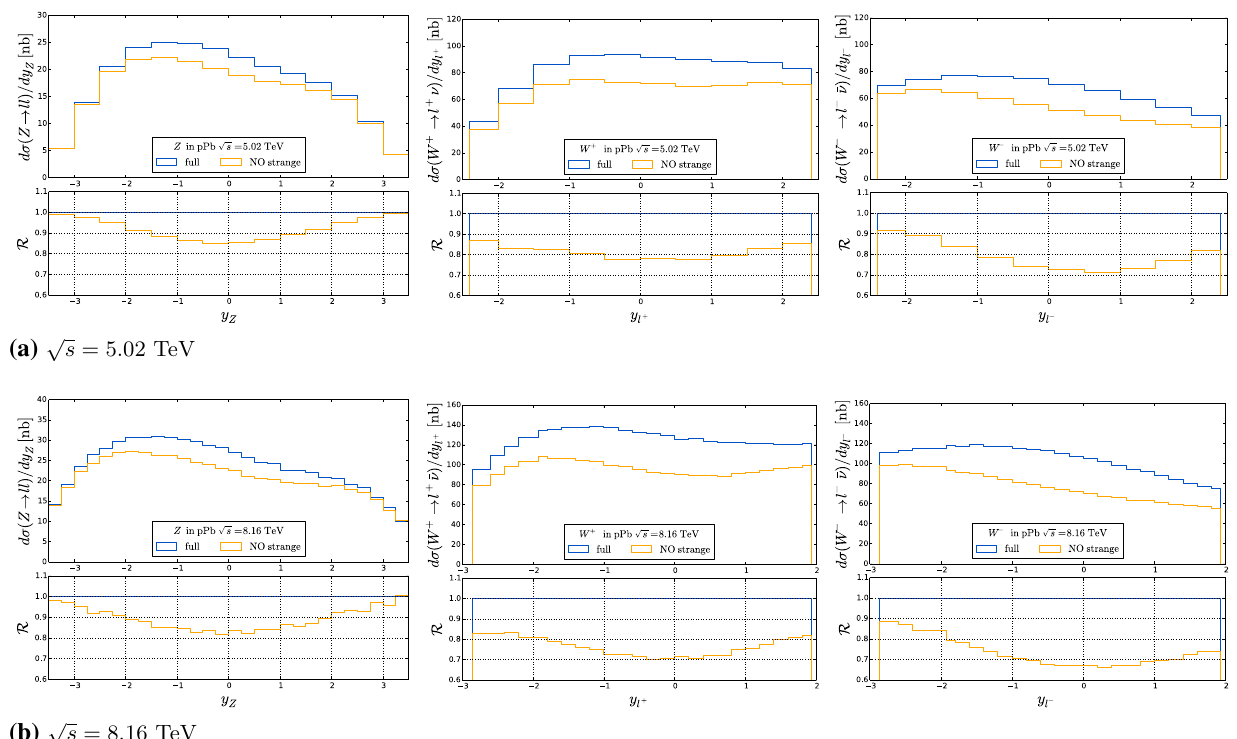
Fig. 1 Contribution of strange initiated channels to W ± and Z boson production for proton-lead ( p Pb) at the LHC. The blue lines represent total cross-sections, the yellow lines are cross-sections with the strange